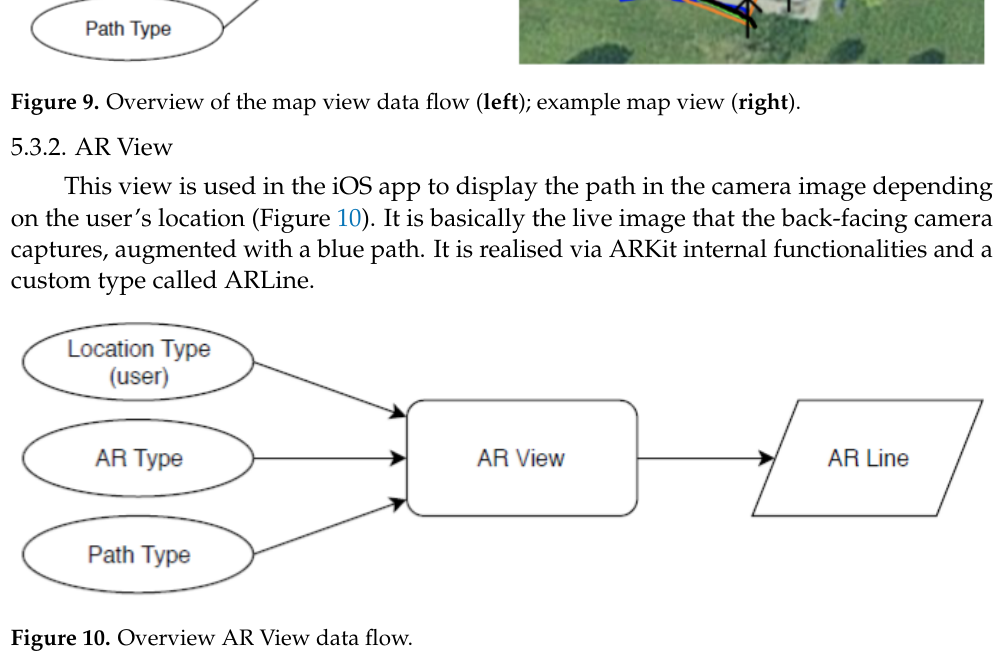
Figure 10. Overview AR View data